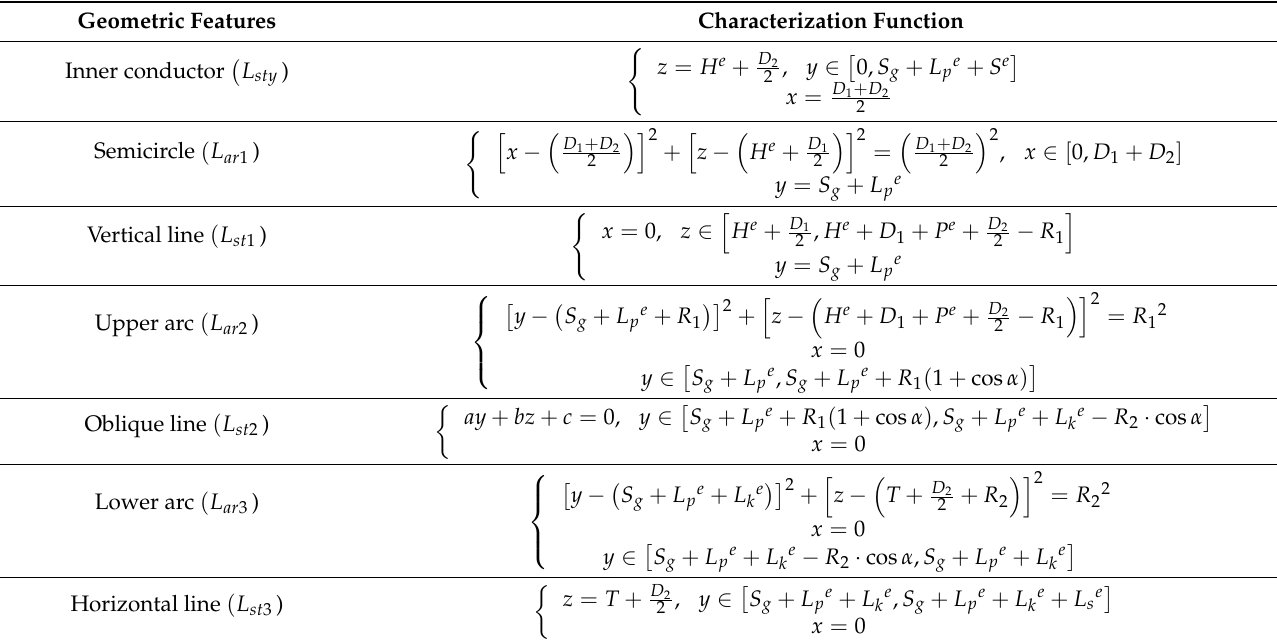
Table 2. Sectioned function characterization of FCWI